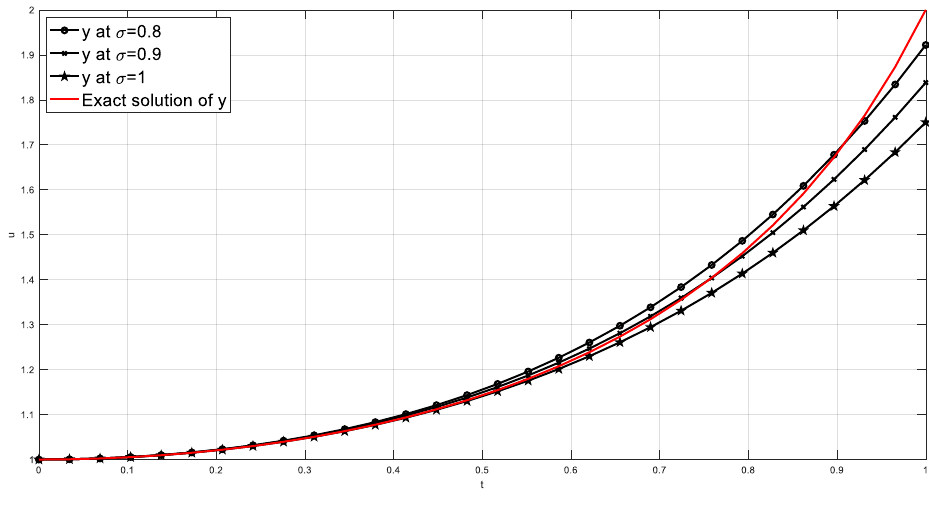
Figure 3. Approximate and exact solutions of Equation (26).